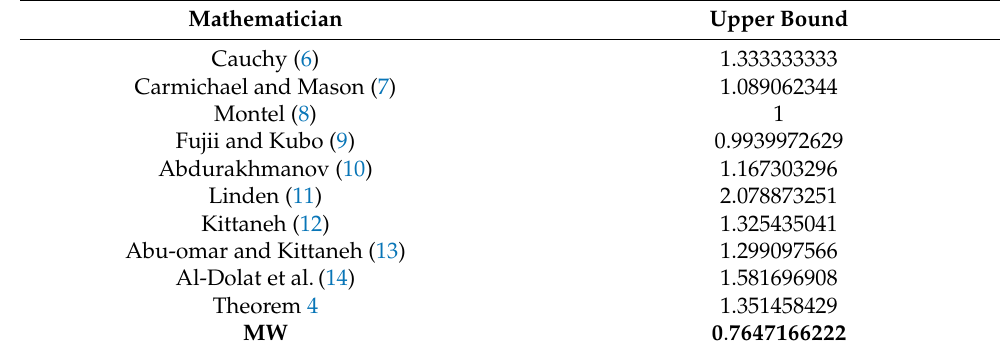
Table 5. Comparisons of upper bounds based on the considered polynomial q 5 ( z )